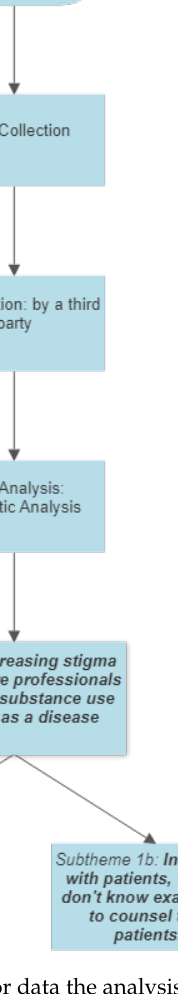
Figure 1. Flow chart for data the analysis of the data collected.